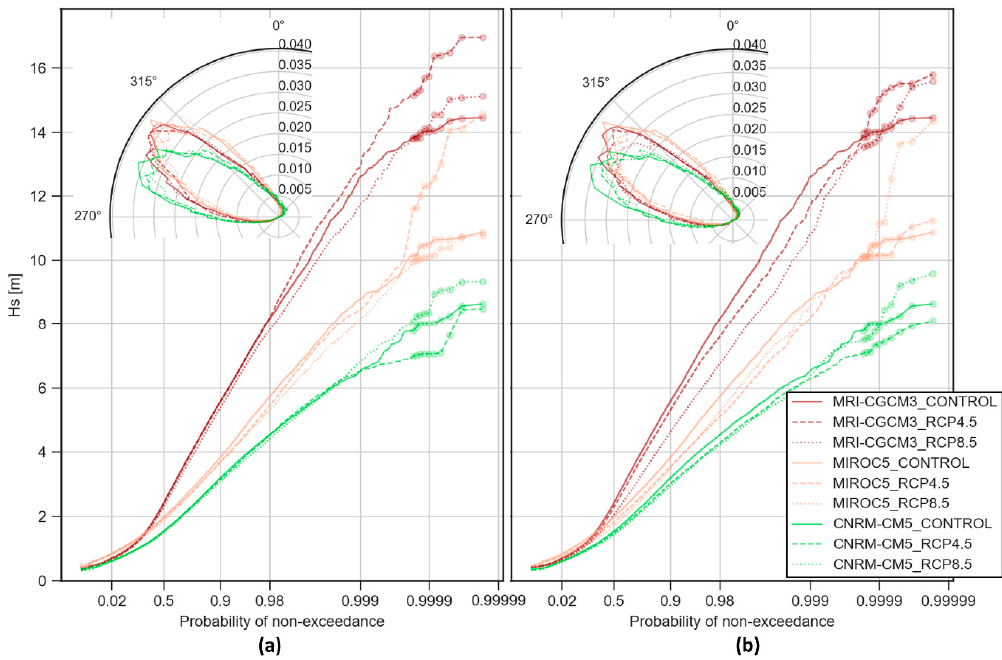
Figure 6. CDFs of the propagated values of H S at deep waters with a detail of the polar PDFs of wave directions for: ( a ) Control simulations and short-term simulations (2026–2045) of all models and concentration scenarios; ( b ) Control simulations and long-term simulations (2081–2100) of all models and concentration scenarios.